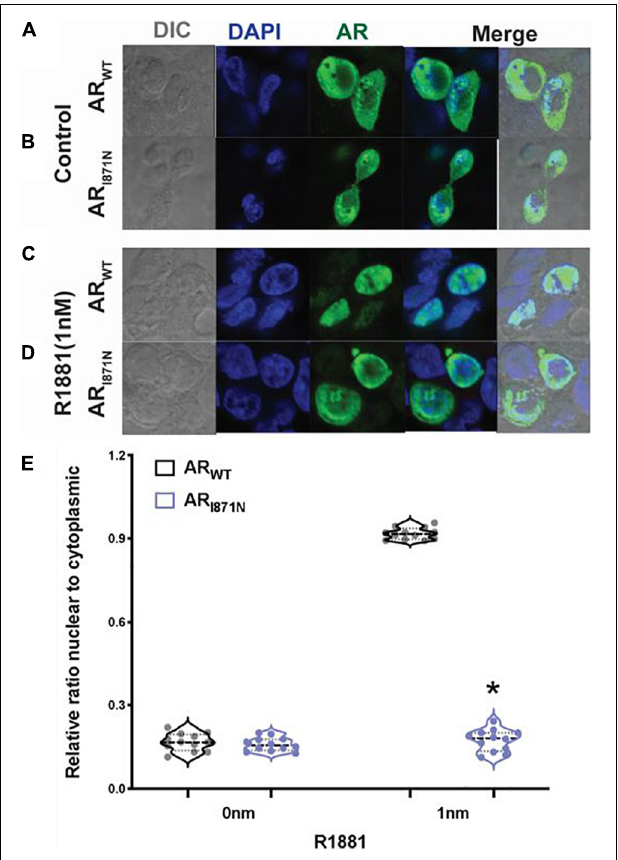
FIGURE 2 | Sub-cellular localization of AR WT and AR I871N . Confocal microscope images of CHO cells transfected with 1 ug of AR WT or AR I871N in the absence of ligand (A,B) or in the presence of 1 nM R1881 (C,D) . The bars represent 10 µ m. (E) Quantitation of the ratio of nuclear/cytoplasmic expression of AR. * P < 0.05 compared with wild